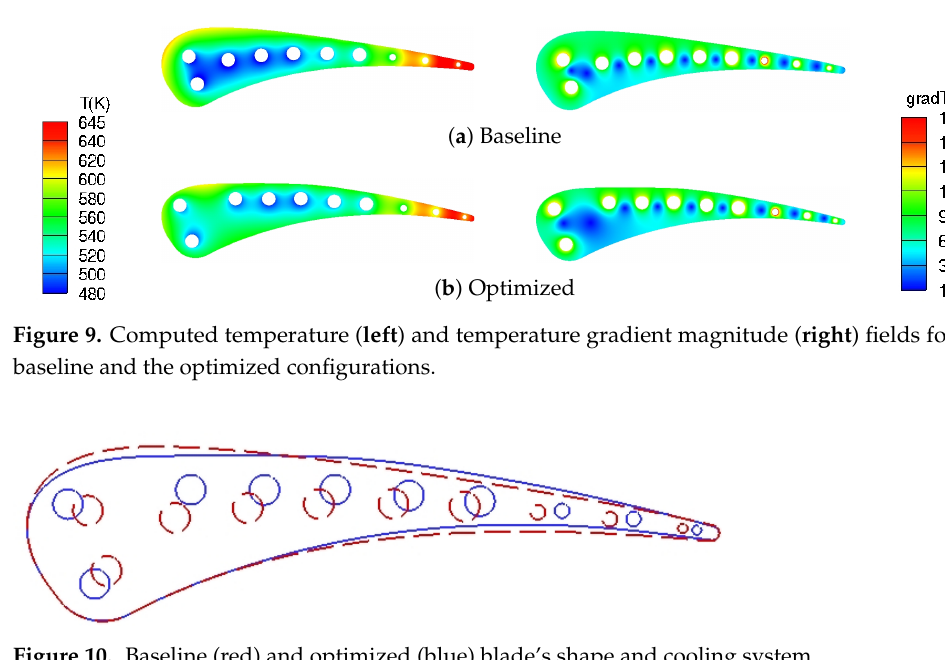
Figure 10. Baseline (red) and optimized (blue) blade’s shape and cooling